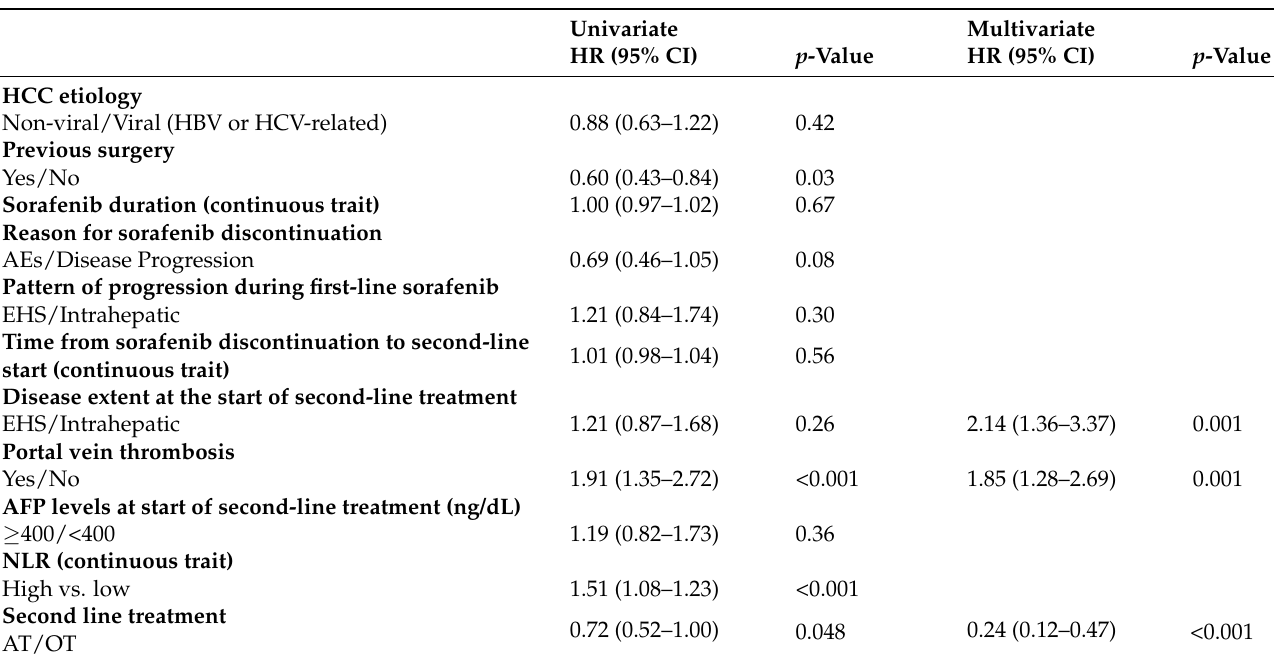
Figure 2. Analysis of disease extent as predictive factor for overall survival benefit from approved treatments. Extrahepatic spread ( A ) and intrahepatic disease ( B ), p value for disease extent treatment interaction = 0.005. 3.3. Overall Survival from Start of Sorafenib Patients from start of sorafenib had a median OS of 22.2 months (95% CI 18.9 – 24.6). Of note, for patients receiving OT, median OS was 21.9 months (95% CI 17.5 – 24.6), while for patients receiving AT median OS was 22.8 months (95% CI 18.4 – 28.1; p = 0.211). Com- pared with OT, survival rates with AT were higher, at 36 months after start of sorafenib through 60 months (Table 4).